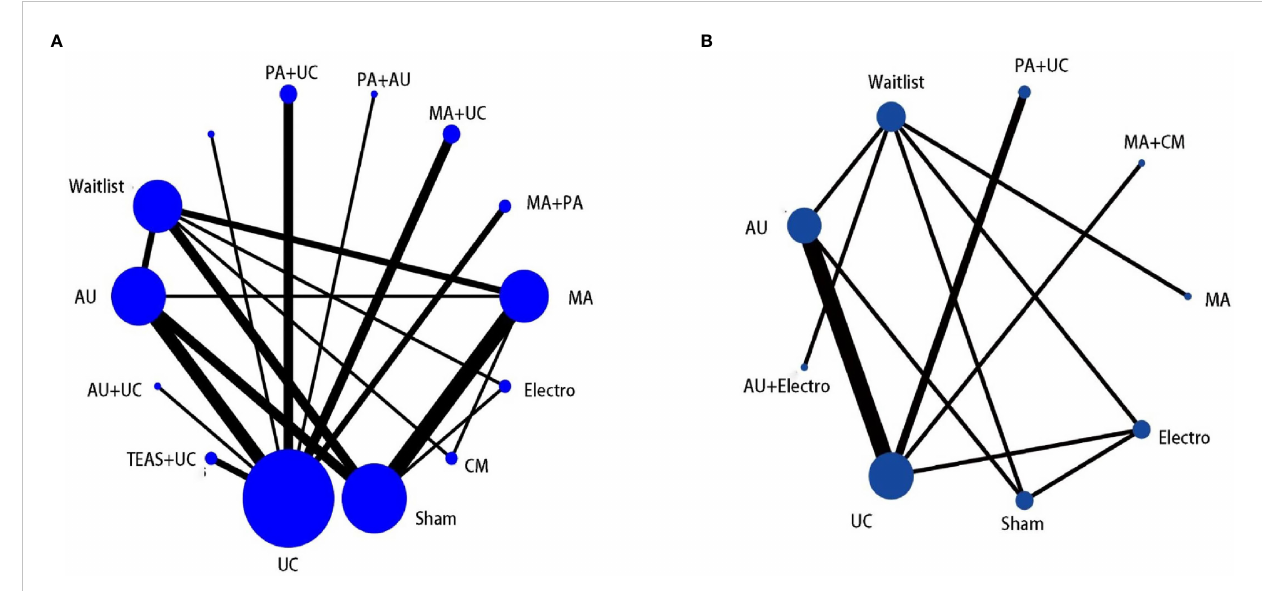
FIGURE 3 (A) The network graph of different interventions of CFS; (B) The network graph of different interventions of